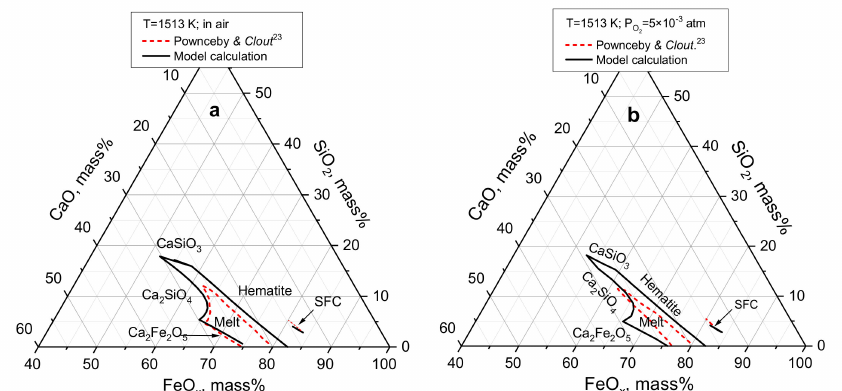
Figure2. ThecomparisonofthecalculatedandexperimentalmeasuredphasestabilityofFeO x -CaO-SiO 2 system [23] at 1513 K and oxygen partial pressure of ( a ) 0.21 atm and ( b ) 5 × 10 − 3